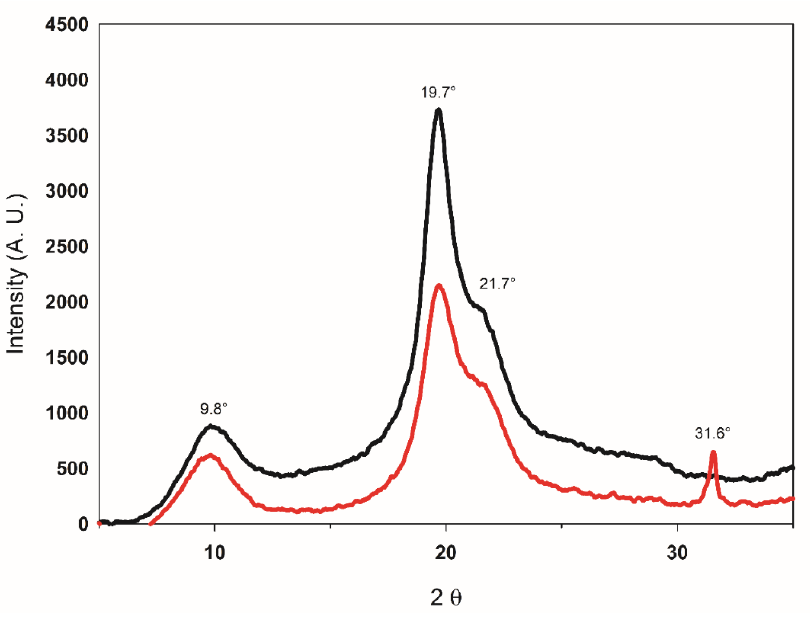
Figure 3. X-ray diffractograms of the CC ( ─ ) and UC ( ─ ).